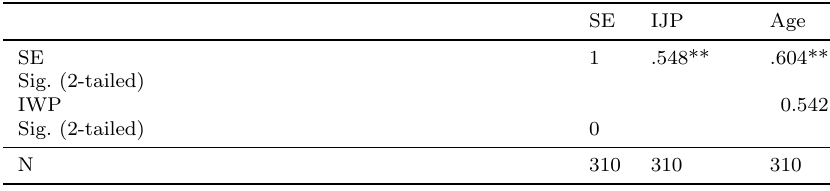
Table 2: Correlation